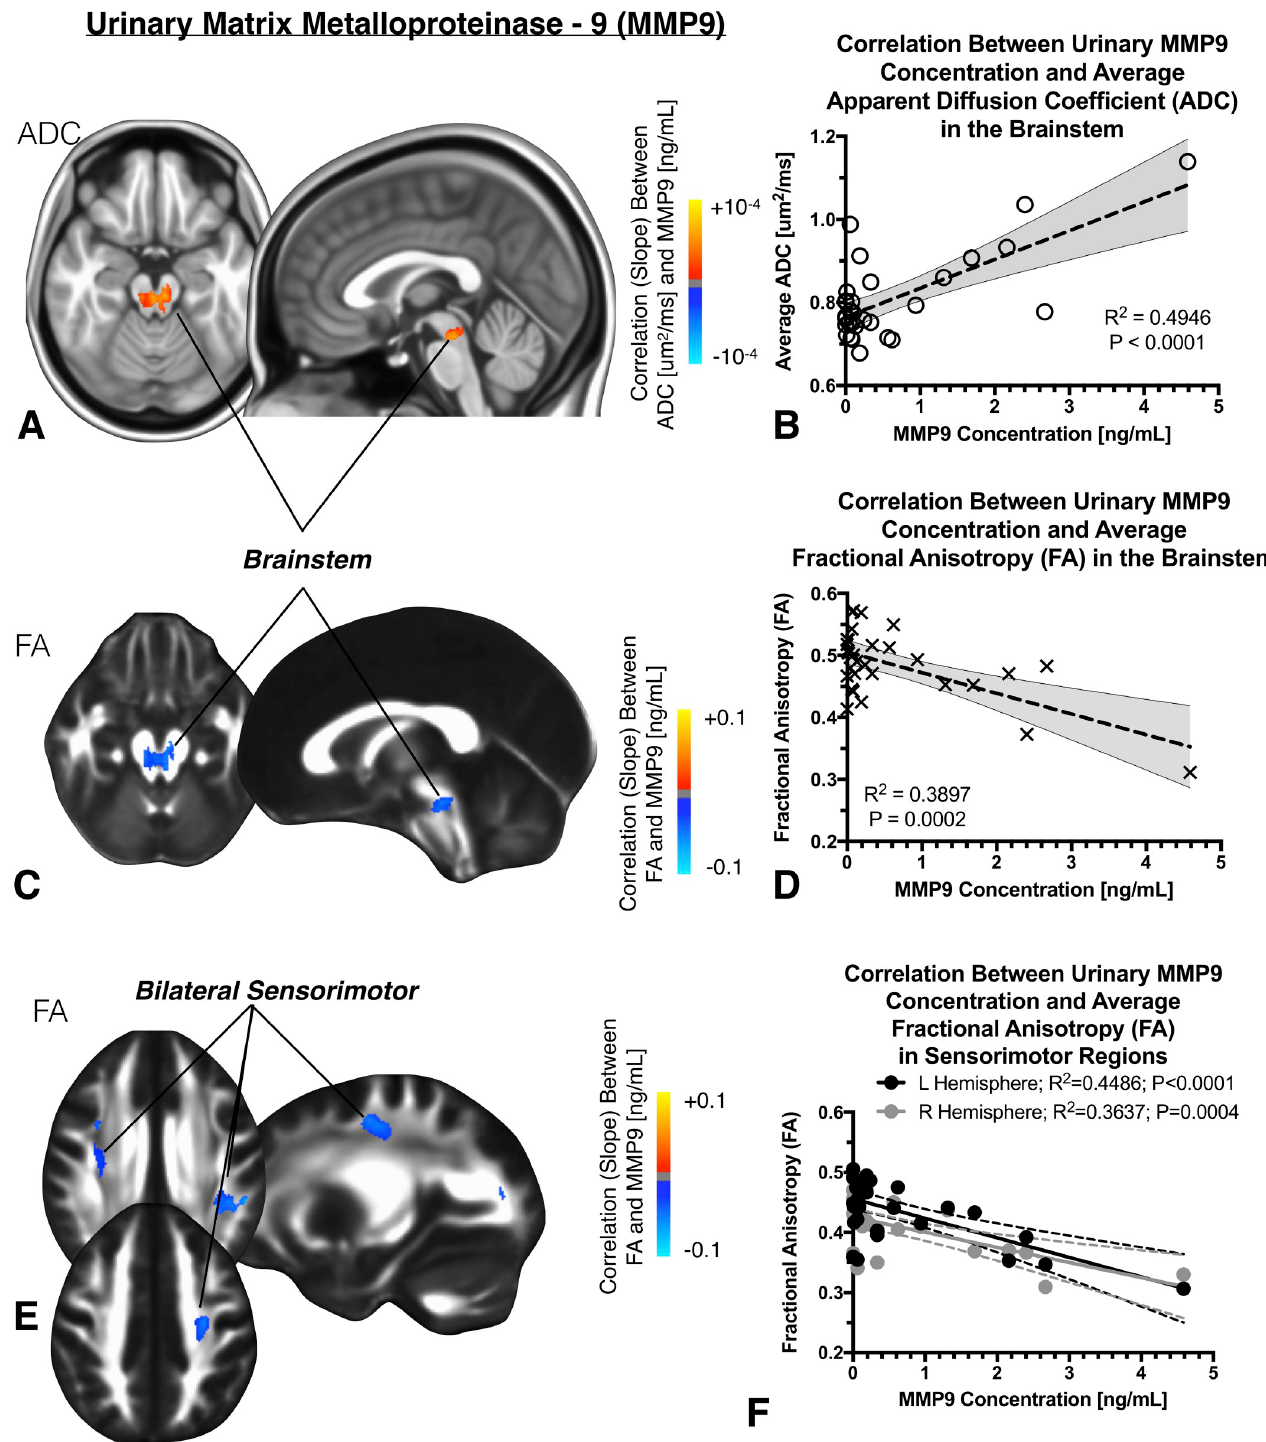
Fig 2. A) Anatomic localization of regions in the brain exhibiting a significant linear correlation between ADC and urinary protein concentration of matrix metalloproteinase-9 (MMP9) within the midbrain portion of the brainstem, encompassing the dorsal Raphe nuclei (DRN). B) Linear correlation between average ADC within this cluster and urinary MMP9 concentration. C) Anatomic localization of regions in the brain exhibiting a significant linear correlation between fractional anisotropy (FA) and MMP9 also present in the brainstem. D) Linear correlation between average FA within this cluster and urinary MMP9 concentration. E) A second set of clusters with a significant linear correlation between FA and MMP were localized to the sensorimotor regions, bilaterally. F) Linear correlation between average FA within these two clusters and urinary MMP9